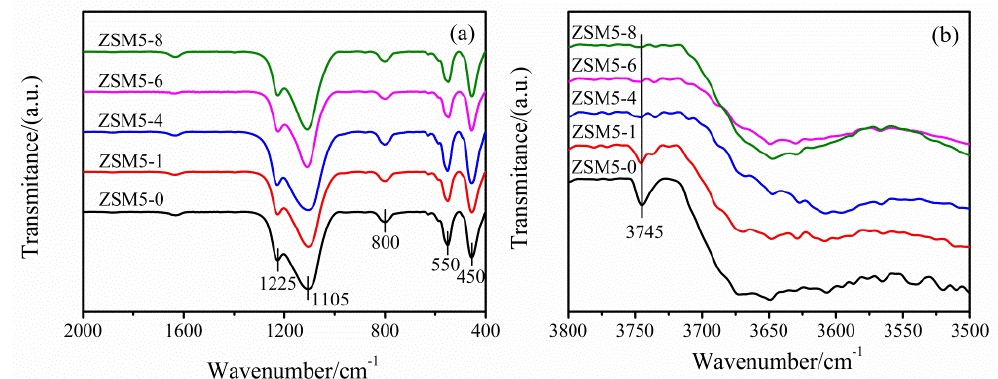
Figure 5. FTIR patterns of ZSM-5 zeolite synthesized with different ethanol